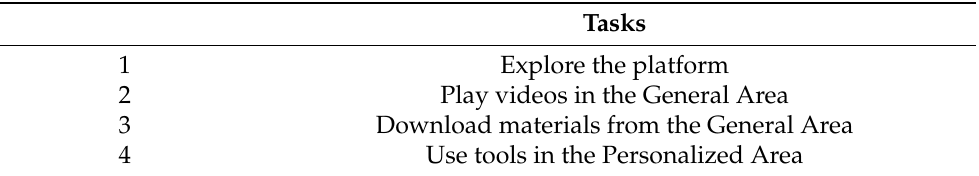
Table 3. Task checklist for the usability test. The table reports the tasks that the users had to perform during their usability test